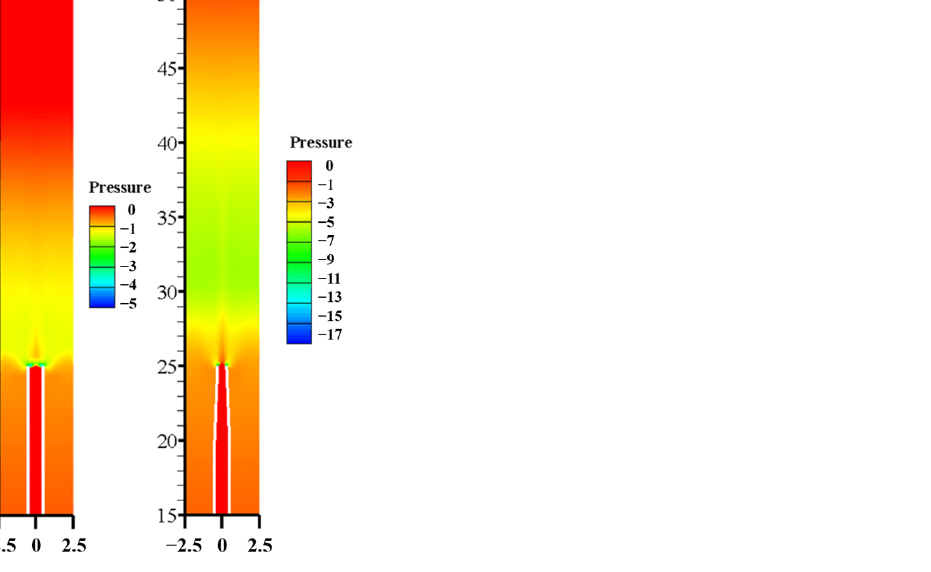
Figure 9. A comparison between the pressure fields in the two combustors with different nozzle exit diameters at V f = 25 m/s: ( a ) d = 0.8 mm and ( b ) d = 0.4 mm.